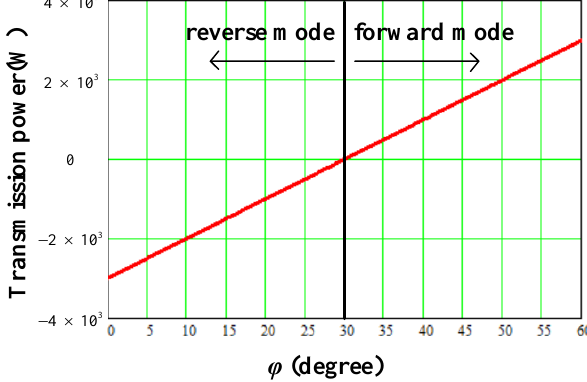
Figure 4. Transmission power curve.